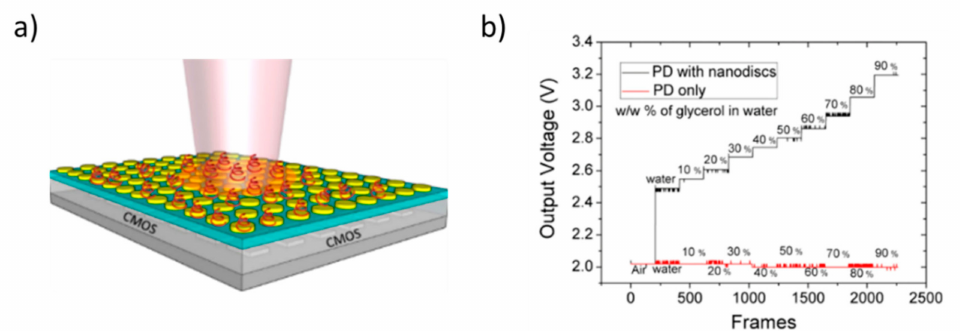
Figure 13. Schematic representation of a nanophotonic complementary metal oxide semiconductor (CMOS)-based biosensor ( a ) and the corresponding response at increasing glycerol concentration in water ( b ). The sensor is based on the monolithic integration of plasmonic nanostructures and a CMOS photodetector. © 2020 American Chemical Society, adapted with permission from